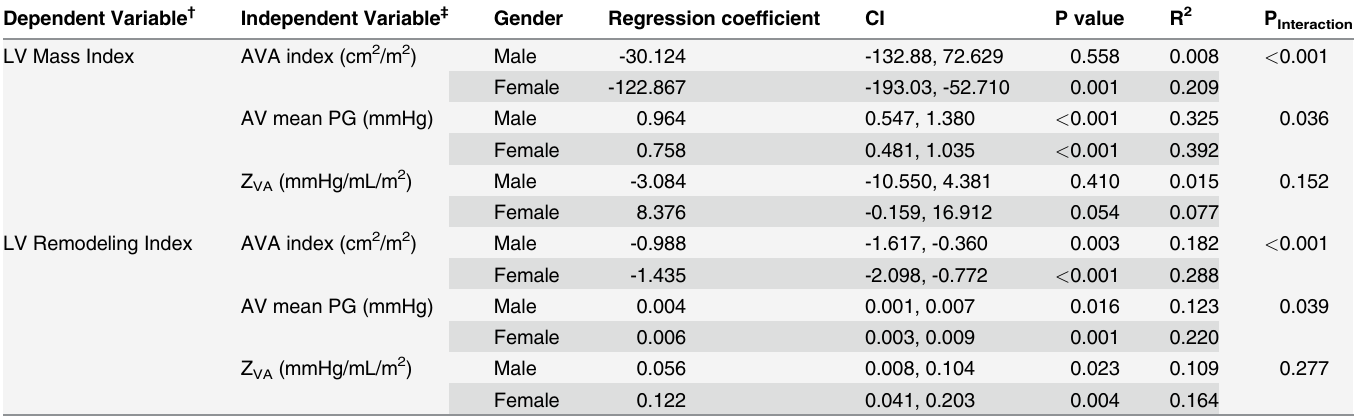
Table 4. Univariate analysis of the association and gender specific interaction between the indexed left ventricular mass or remodeling index and parameters of aortic stenosis severity, with exclusion of the patients with moderate AS.